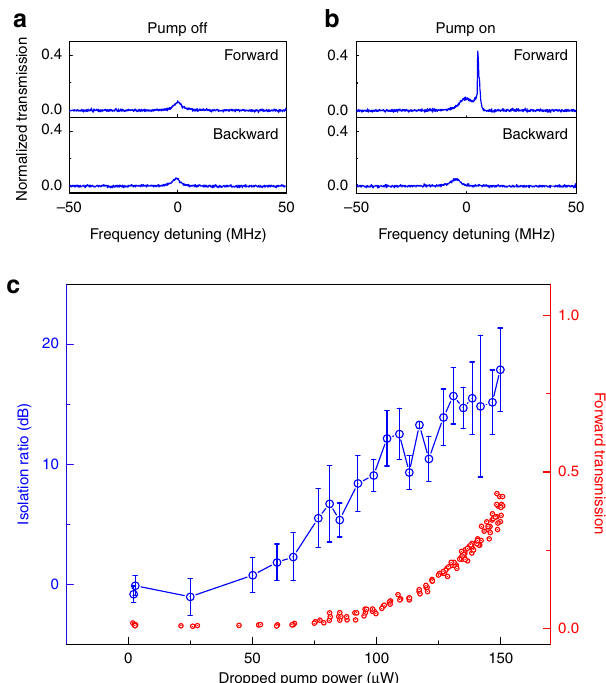
Figure 2 | Optical isolation versus dropped pump power in the two-fibre- coupling case. ( a ) With pump off, as expected, reciprocal transmission is obtained. The single peak appearing in both forward and backward transmission spectra indicates negligible backscattering effect in the microcavity. ( b ) With pump on, typical asymmetric transmission spectra are observed when the parametric gain compensates the loss. The sharp peak in forward transmission marks the centre of the parametric gain. ( c ) Measured optical isolation ratio as a function of the dropped pump power (blue circles). In contrast, the normalized forward signal transmission (red circles) bears with a smooth behaviour. The error bars are the standard deviation of the measured isolation ratios under same pump conditions, which suggest the isolation uncertainty be mostly owing to the backward transmission. Parameters: the simultaneous presence of equal forward and backward signal power is 5.6 m W, k 1 ¼ 2 p (cid:2) 1.95MHz and k 2 ¼ 2 p (cid:2)